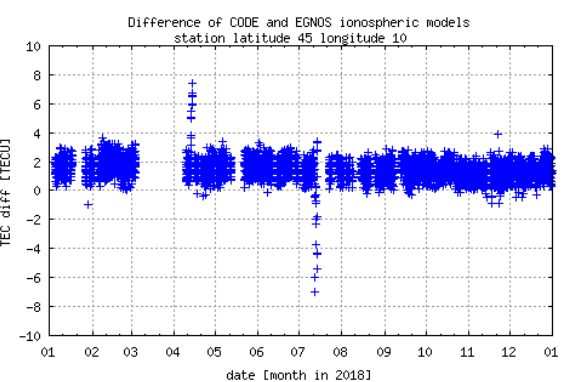
Figure 9. Discrepancies between EGNOS and CODE model at a given grid point.